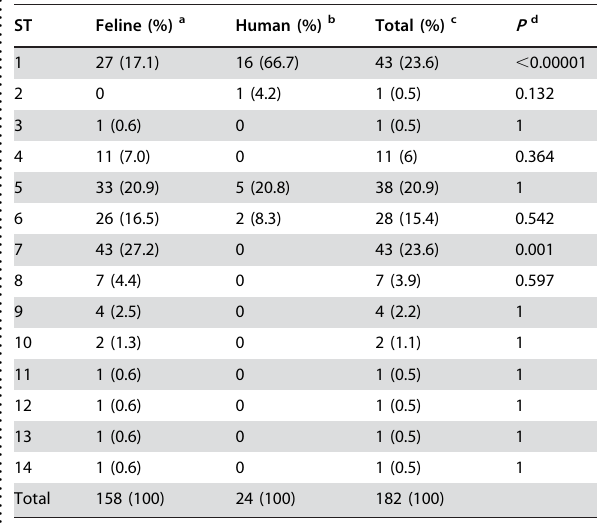
Table 3. Correlation between ST and host species in 182